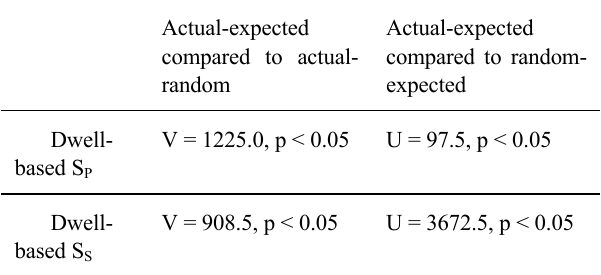
Table 1. Statistical results for countryside